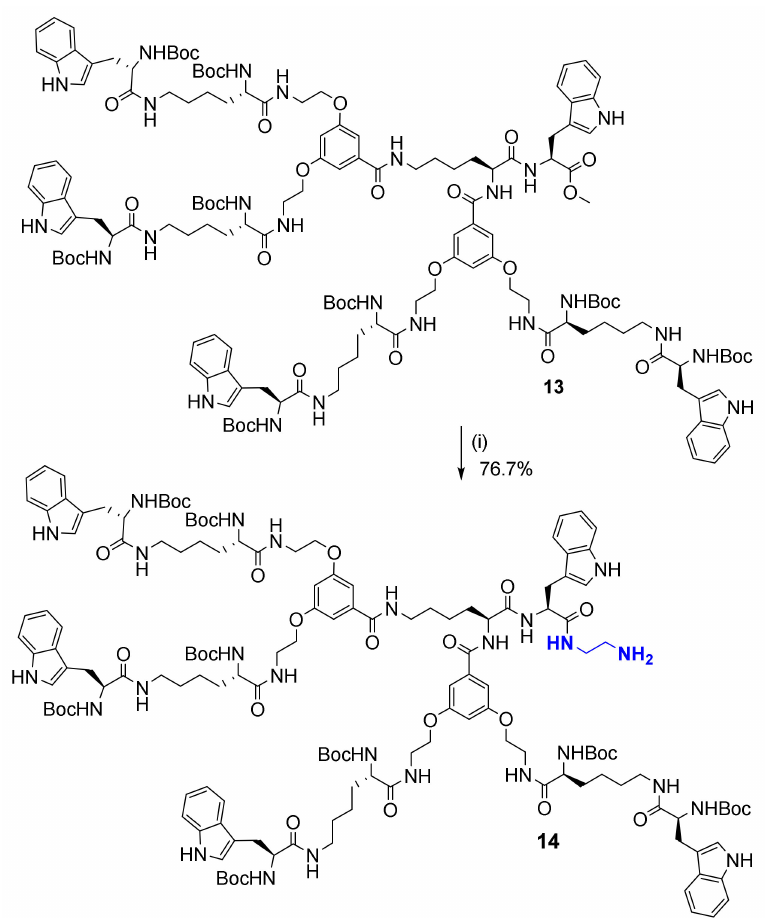
Scheme 3. Synthesis of Trp terminated dendron 14 with EDA spacer constituting left side of the bola structure. Conditions: ( i ) EDA, MeOH, r.t., 10 days ( 14 described in ref.